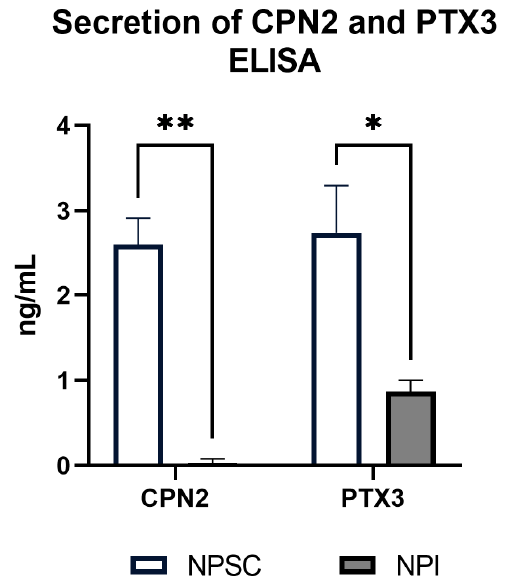
Figure 6. NPSCs and NPIs secreted protein expression of Cpn2 and Ptx3. ELISA assays were performed to quantify Cpn2 and Ptx3 protein secretion by NPSCs (white bar) and NPIs (gray bar). Significance was calculated using the unpaired t-test. * p < 0.05. ** p < 0.01.